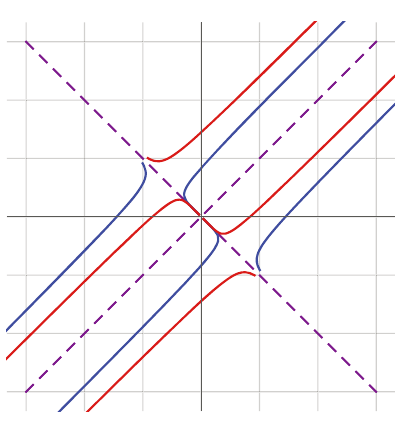
Figure 6: Spacelike ( blue ) and timelike ( red ) curves in (cid:2) 2 such that (cid:2) ( ) = + ρ ρ ρ 2 .